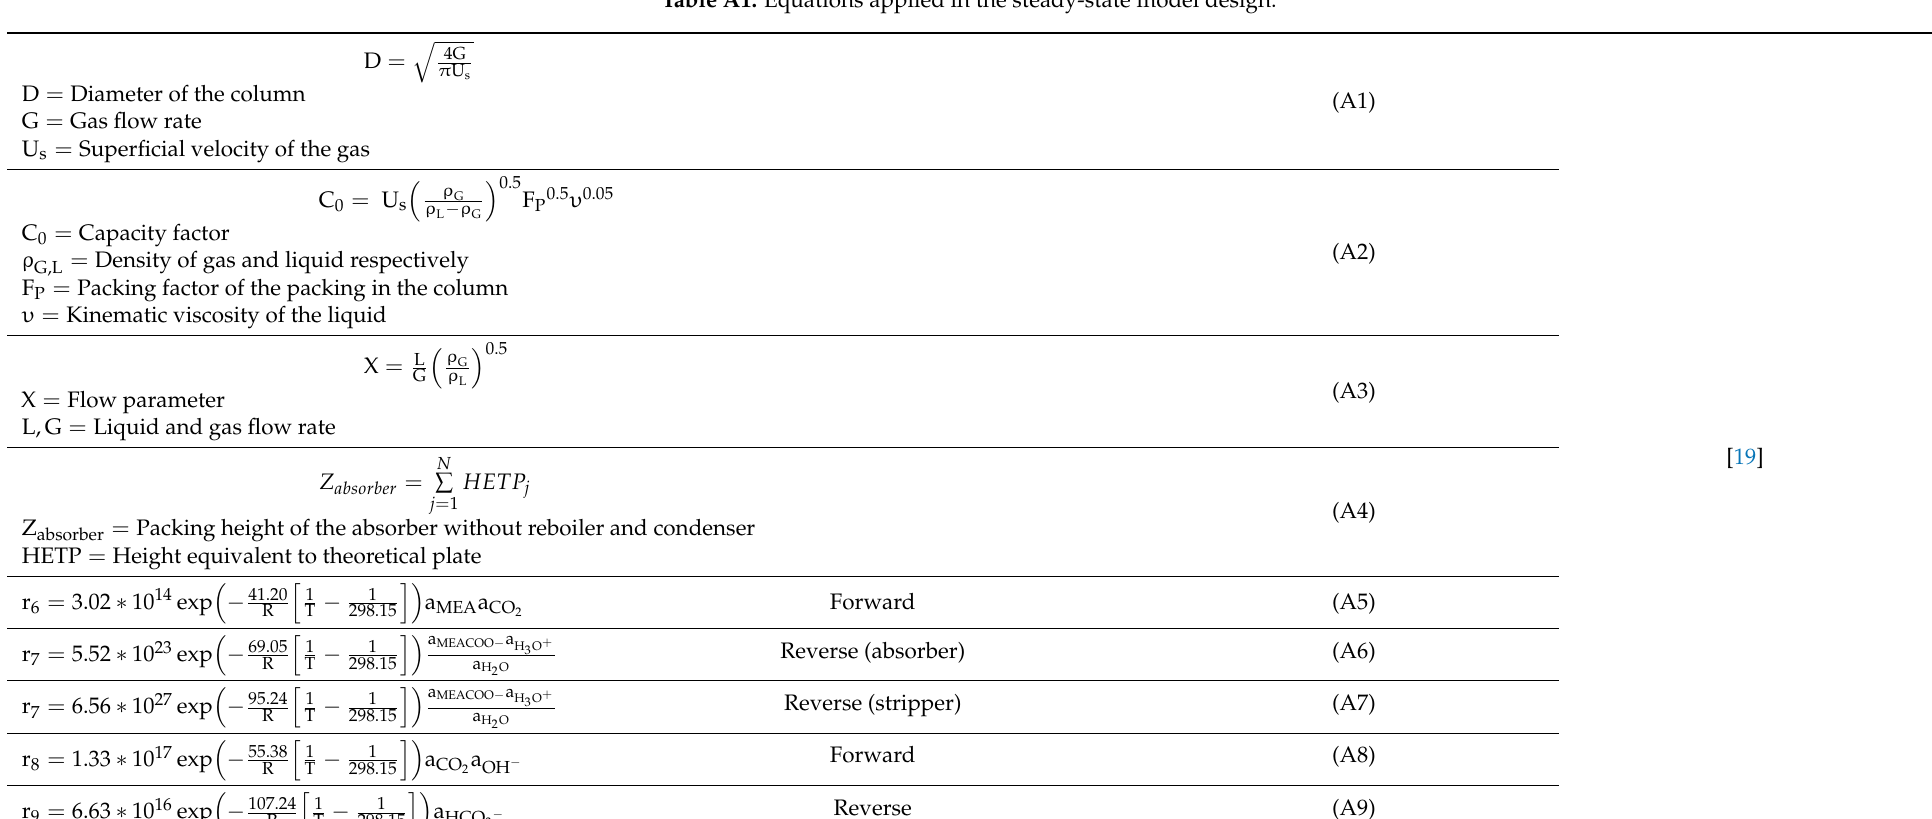
Table A1. Equations applied in the steady-state model